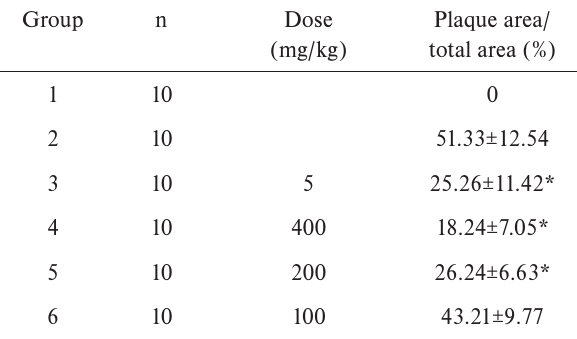
Table 3. Aortic staining results (x ±